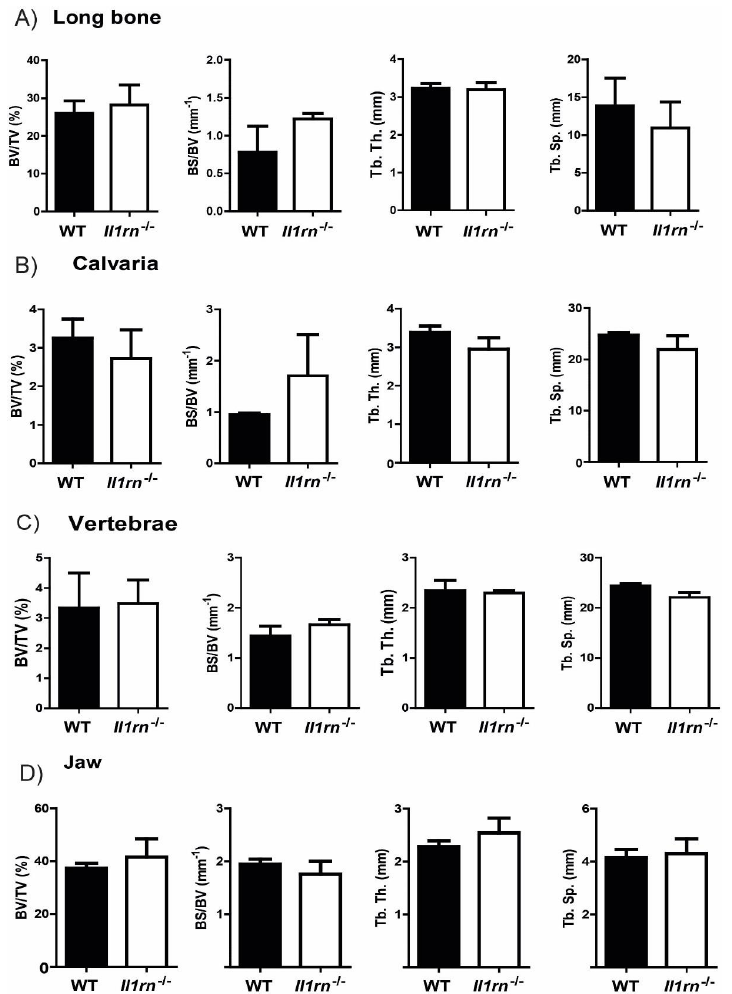
Figure 1. MicroCT analysis of WT and Il1rn − / − mice showed no di ff erences in bone microstructure independently of the skeletal site. To assess possible bone destruction at the di ff erent skeletal sites, various 3-D microstructural bone parameters, including bone volume fraction (BV / TV), specific bone surface (BS / BV), trabecular thickness (Tb.Th.), and trabecular separation (Tb.Sp.), were measured in all specimens from Il1rn − / − mice and wild-type (WT) controls ( A – D ) ( n = 3 mice / group). These parameters were comparable between the two mouse strains irrespective of the bone site, suggesting that these Il1rn − / − mice did not develop structural pathology